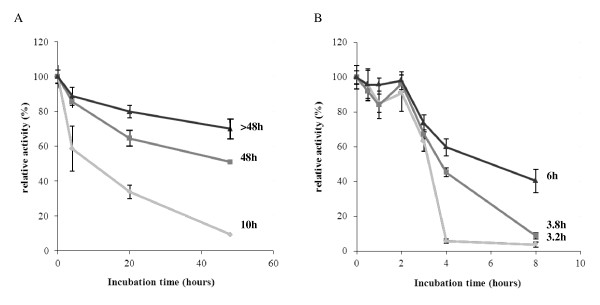
Thermostability of PpCel45A and its derived constructs. Thermostability profiles at 65°C (A) and 80°C (B). Light gray: PpGH, dark gray: PpCBM15:GH, black: PpCel45A. Half-lives of the three constructions are indicated on the right.